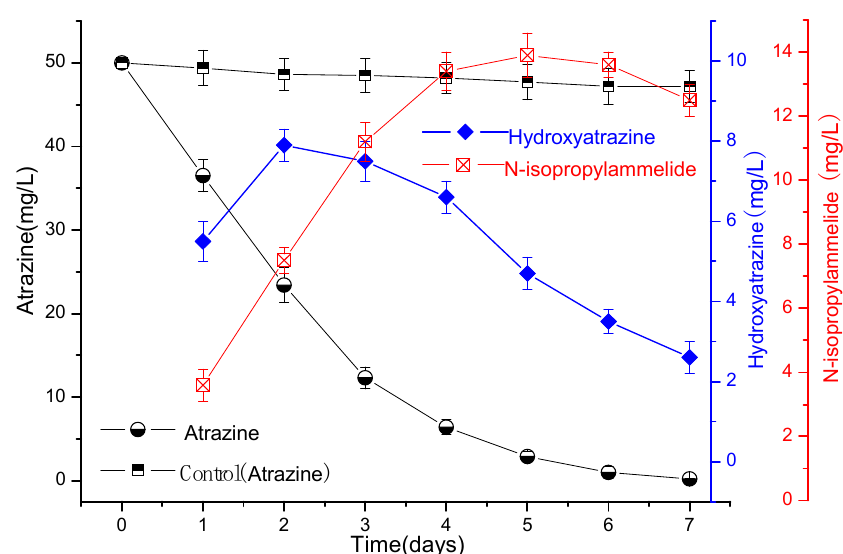
Figure 3. The curve of the degradation of atrazine by the strain ATLJ-5.